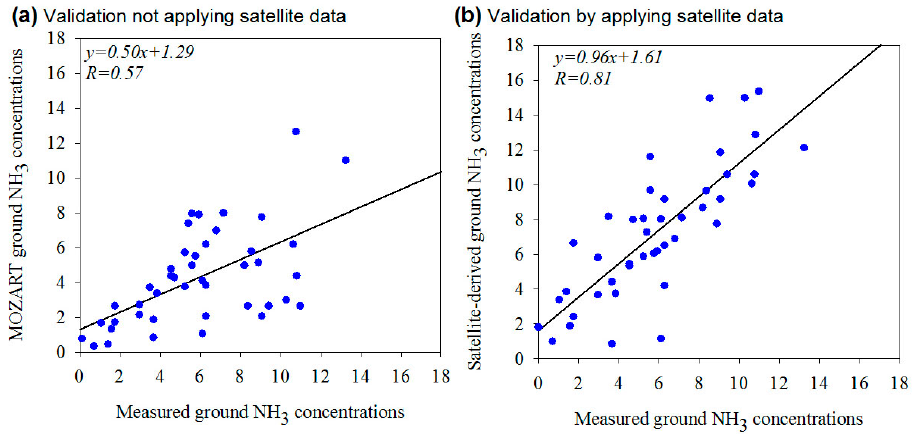
Figure 4 . Yearly comparisons between the estimated and measured ground NH 3 concentration (µg N m − 3 ). ( a ) indicates the comparison between the measured ground NH 3 concentrations and the estimated ground NH 3 concentrations from MOZART at the lowest layer before applying the satellite data, while ( b ) represents the comparison between the measured and estimated ground NH 3 concentrations by applying the satellite data using the methods in Section 2.4.